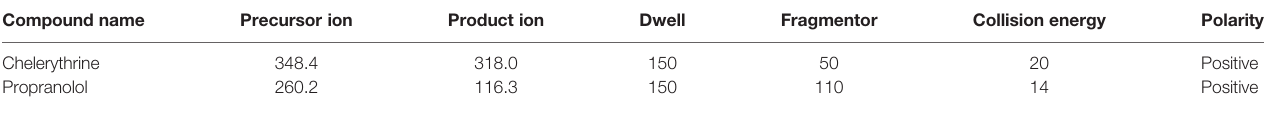
TABLE 3 | Parameters of